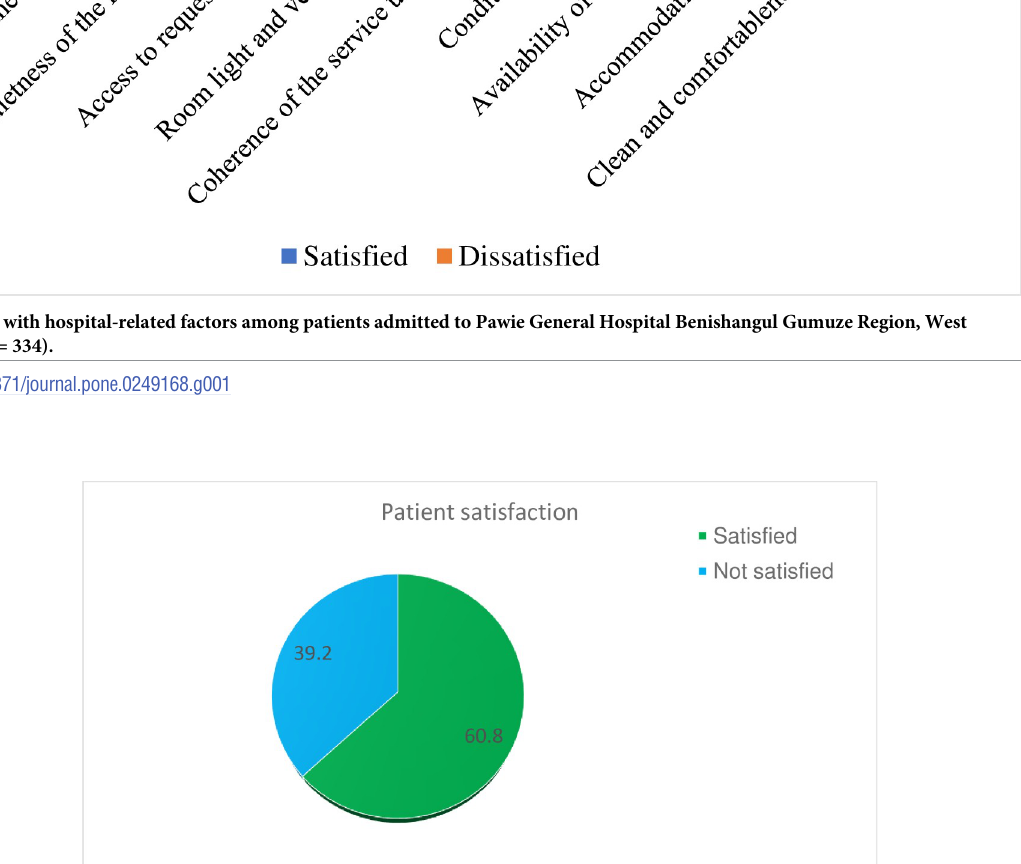
PLOS ONE | https://doi.org/10.1371/journal.pone.0249168 April 20,